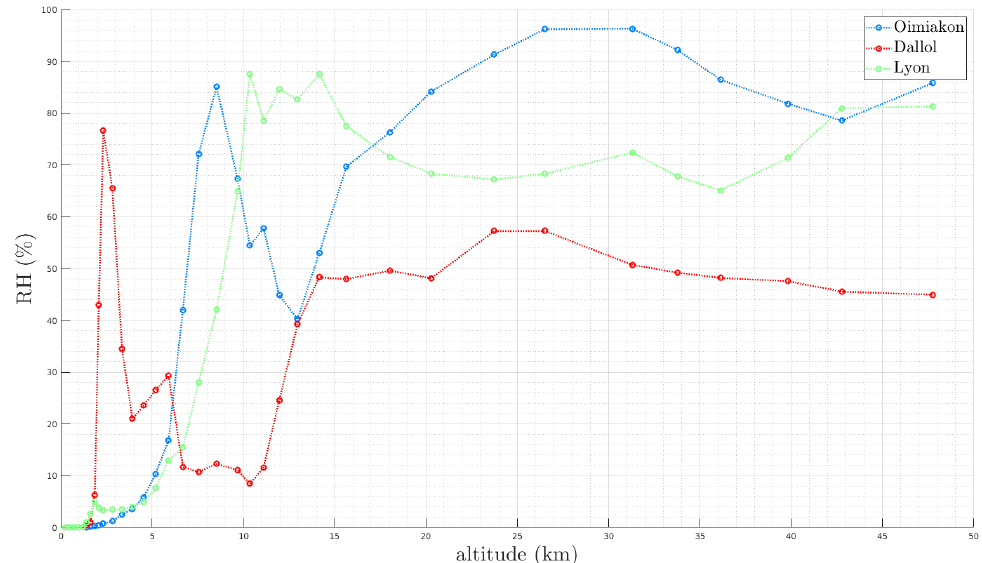
Figure 11. Relative humidity profiles for altitudes from 0 to 50 km of extreme atmospheres: Oimiakon (in blue) and Dallol (in red) and a moderate one, Lyon (in